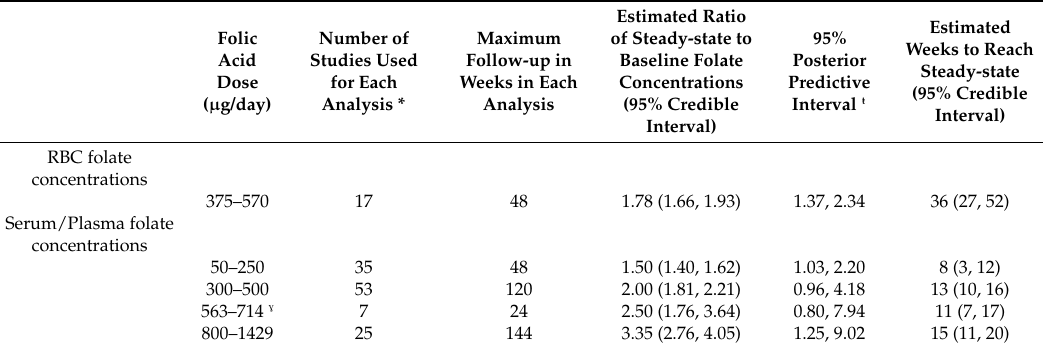
Table 1. Estimated ratio of steady-state to baseline red blood cell (RBC) and serum/plasma folate concentrations and estimated time to reach steady state. Folic Number of Acid Studies Dose ( µ g/day)